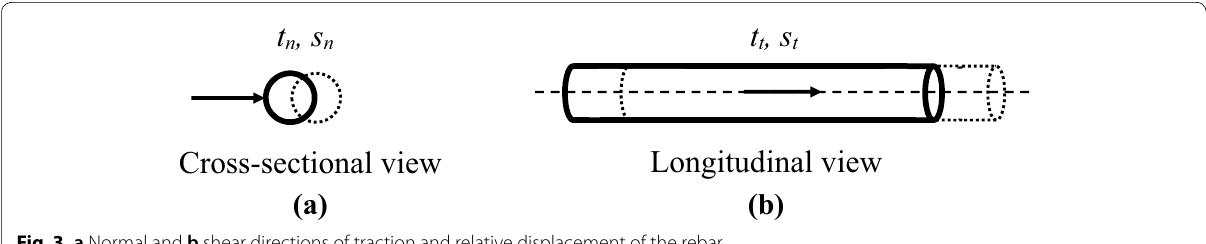
Fig. 3 a Normal and b shear directions of traction and relative displacement of the rebar.